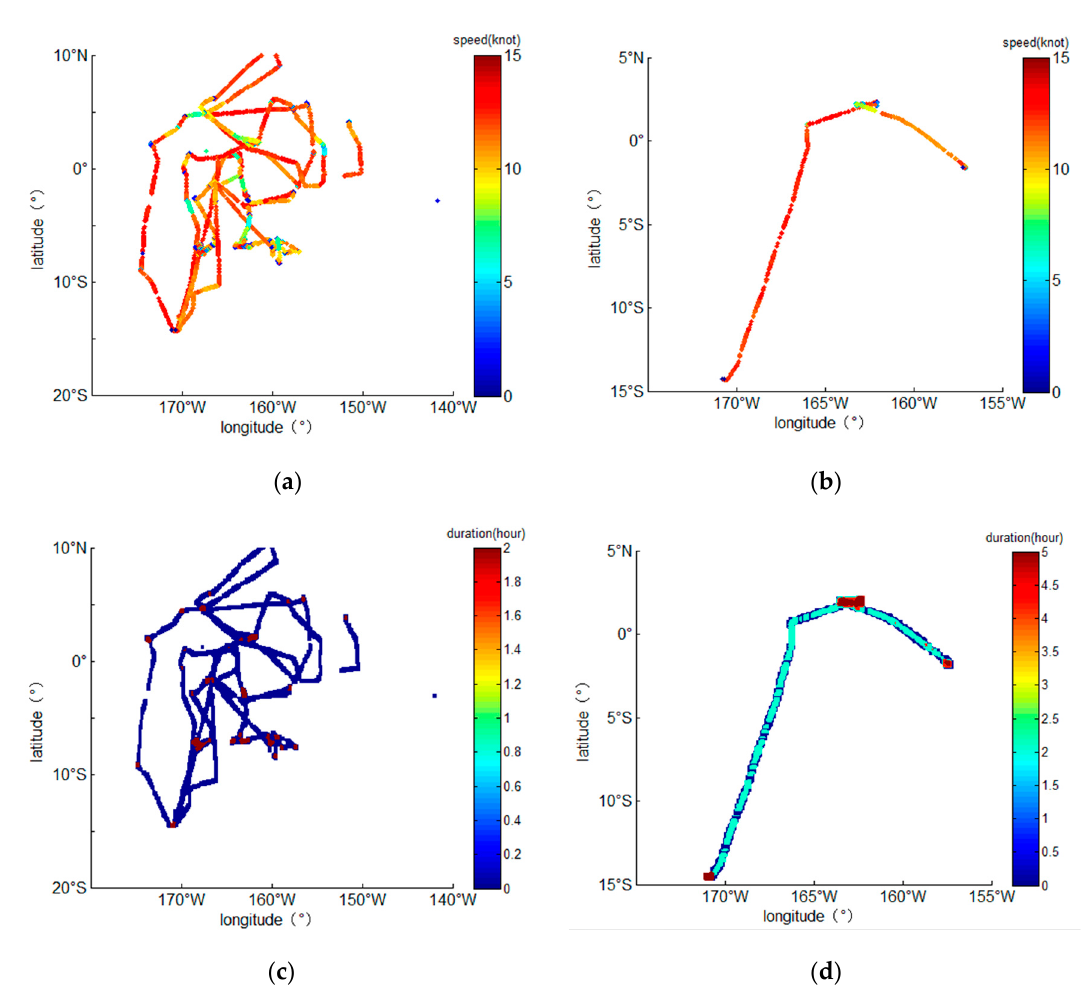
Figure 2. Track characteristics of a single vessel: ( a ) The vessel trajectory velocity from January to May 2018; ( b ) The vessel trajectory velocity from April 15 to 30; ( c ) The spatial diagram of fishing intensity from January to May 2018; ( d ) The spatial diagram of fishing intensity from April 15 to 30.